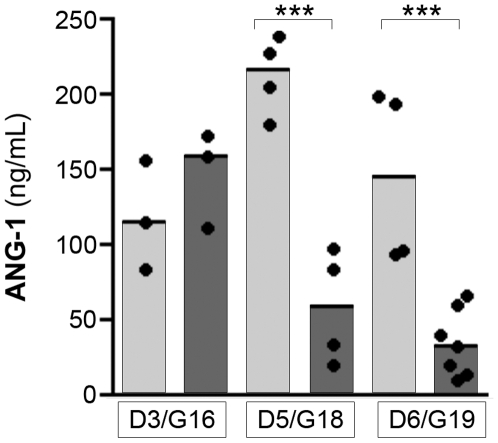
Malaria infection decreases maternal serum ANG-1 in pregnant mice (P <0.001, 2-way ANOVA).Serum ANG-1 levels from uninfected (light bars) and P. berghei infected (dark bars) pregnant mice as measured by ELISA. Dots are individual mice; bars represent the median of each group. *** P<0.001 (Bonferonni post-test). D, day post infection/control injection; G, gestational day.